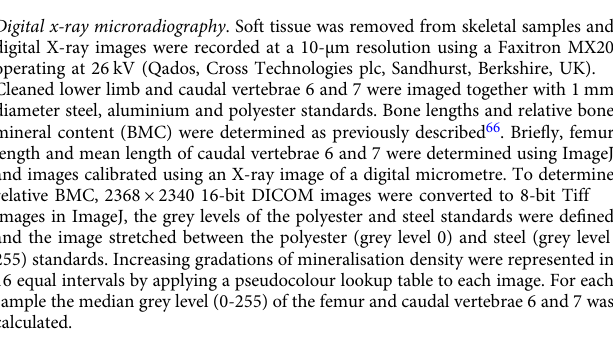
Structural and functional skeletal phenotype analysis of mice with deletions of osteocyte transcriptome signature genes) except that digital X-ray images